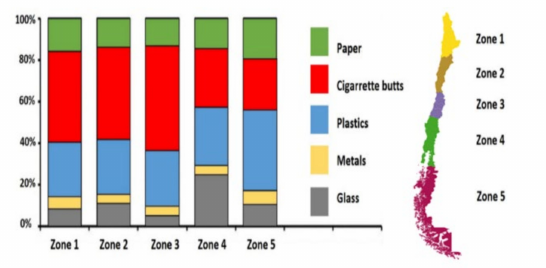
Figure 1. Percentage of di ff erent beach litters in five zones of